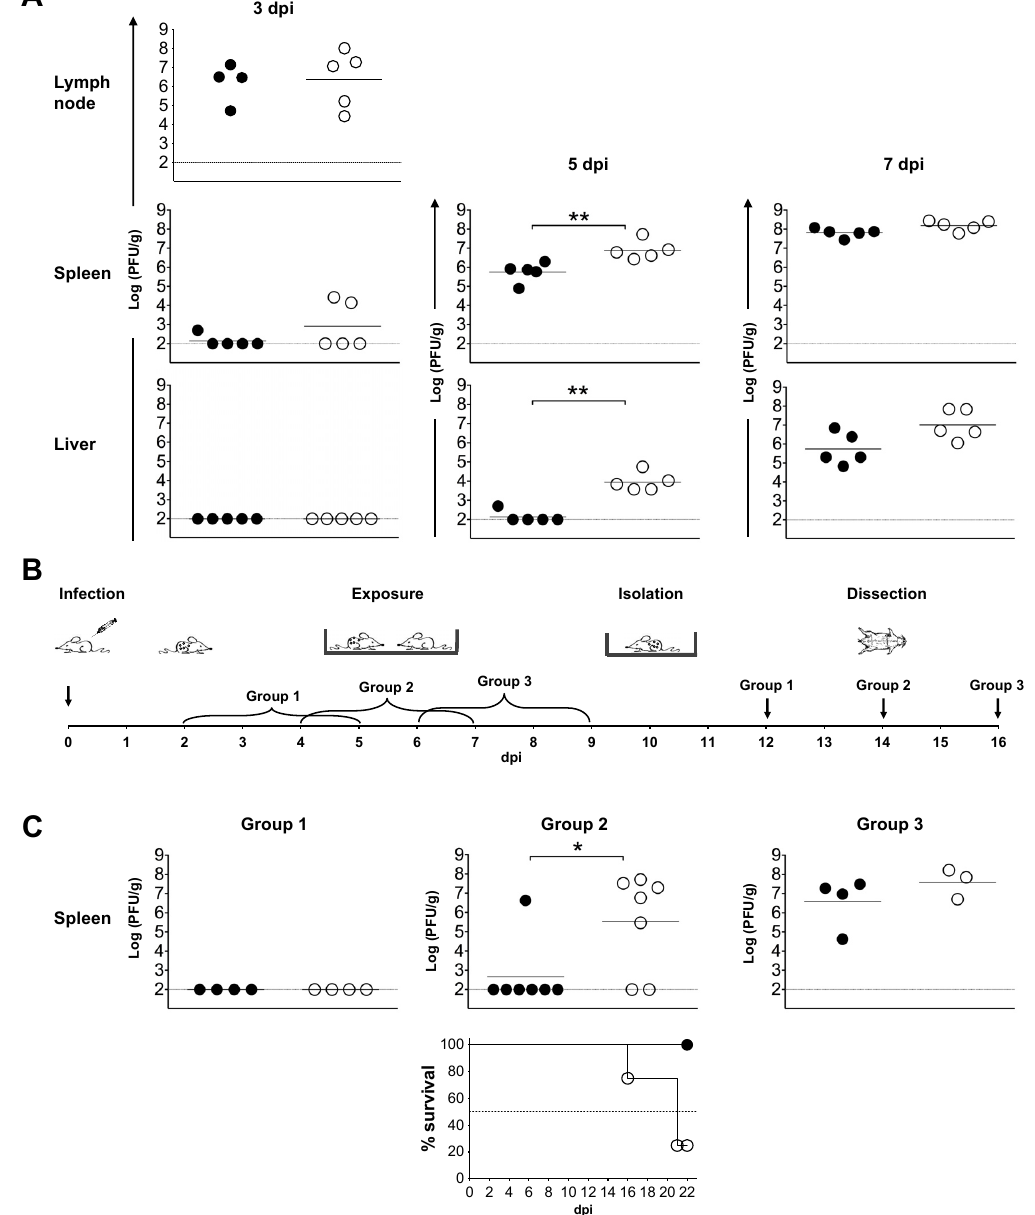
Figure 6. ECTV inclusion into ATI bodies affects its dissemination and transmission. ( A ) Viral dissemination of ECTV-H ( ● ) and ECTV-M ( ○ ) from female BALB/cJ mice s. c. infected in the footpad with 10 pfu. Groups of five ECTV-infected mice were euthanized and virus titer in spleen and liver samples collected at 3, 5 and 7 dpi, and virus in popliteal lymph nodes at 3 dpi, are shown. ( B ) Schematic representation of the in vivo viral transmission experiment: two infected mice at 2, 4 and 6 dpi were housed with four naïve mice during 3 days. Animals were subsequently separated and 7 days post-exposure (dpe) euthanized to collect spleen samples. Infected and recipient naïve mice shared the same cage during “Exposure”, then naïve mice were separated from infected animals (“Isolation”) and the viral load was analyzed in the spleen of the naïve mice 7 dpe. Three different protocols of transmission were carried out as schematically shown in the diagrams below the graphs: group 1 of naïve mice was housed with 2–5 dpi infected mice, group 2 with 4–7 dpi infected mice and group 3 with 6–9 dpi infected mice. ( C ) Viral transmission from ECTV-M and ECTV-H s. c. infected (10 3 pfu) BALB/cJ mice to naïve mice after 3 days of exposure in the same cage. Spleen viral titers are shown at 7 dpe. Viral titers and mortality of group 2 are the result of two independent experiments with 4 and 3 naïve mice, respectively. Statistical significance is shown with * ( p < 0.05), ** ( p < 0.01). Black horizontal lines show geometric means. Gray horizontal line indicates the limit of